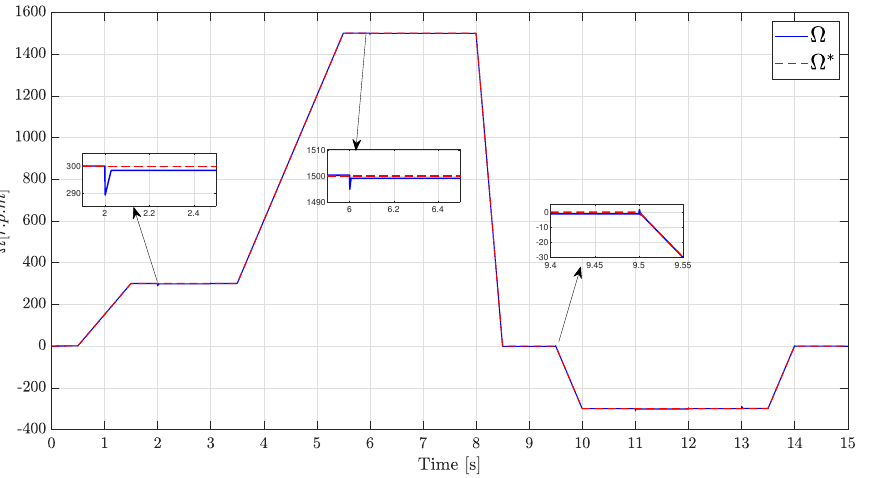
Figure 15. Velocity response obtained by SMC controller and optimal currents calculations